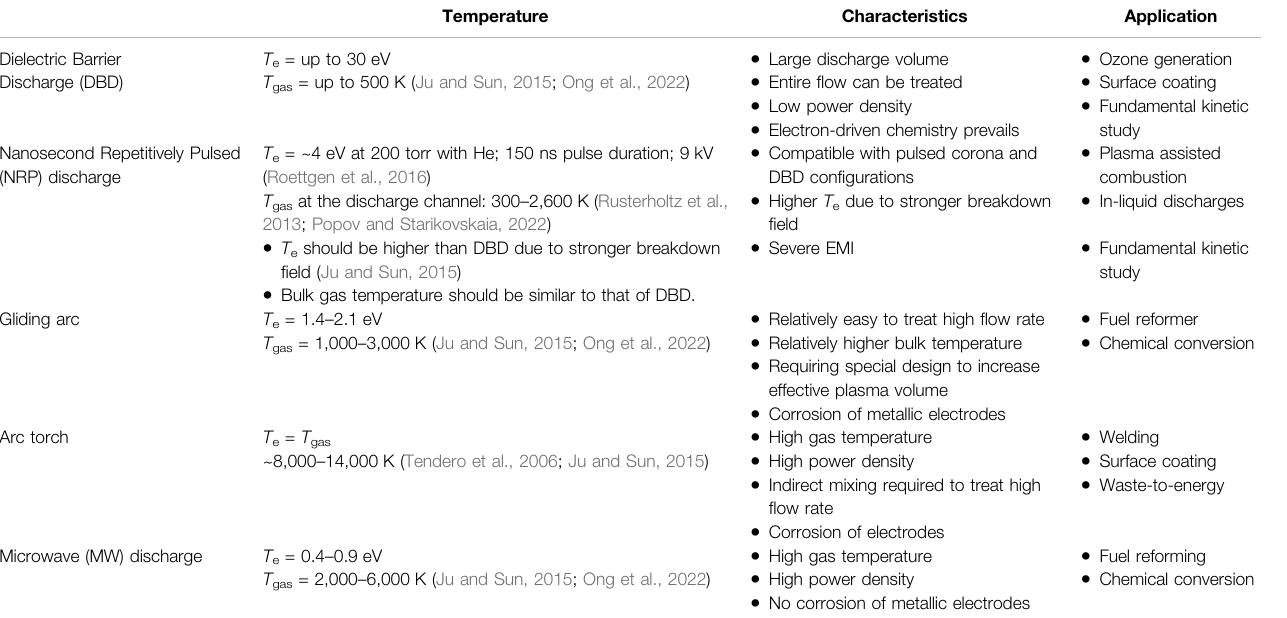
TABLE 1 | Characteristics of the main atmospheric pressure